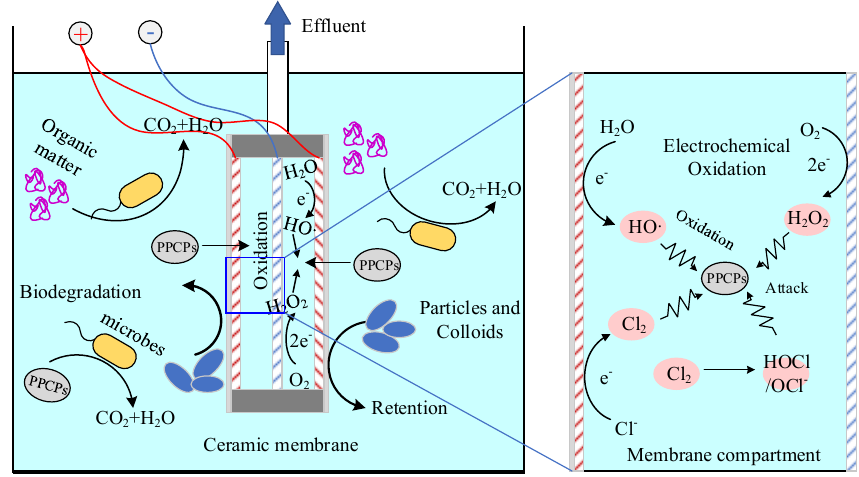
Figure 6. Schematic of the mechanisms for PPCP removal in the ECMBR.